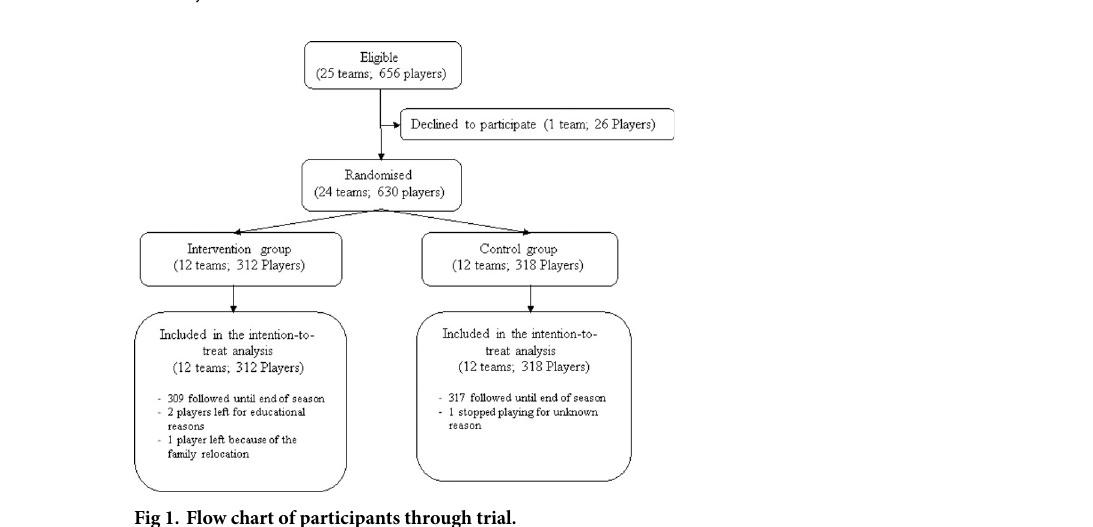
Fig 1. Flow chart of participants through